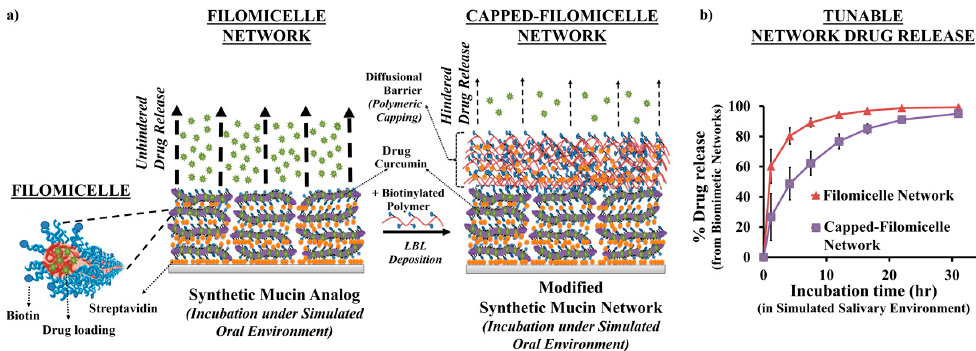
Figure 9. Potential synthetic mucin analogs as a tunable drug releasing network ( a ) Scheme showing use of filomicelle networks formed from crosslinking of biotinylated micelles with streptavidin, as a synthetic mucin analog. And, modification of those analog systems using polymeric capping barriers formed atop synthetic mucin. Capping barriers are formed from crosslinking of biotinylated polymer poly(acrylic acid) with streptavidin via LBL depositions; ( b ) Figure shows modification of drug release capacity from synthetic mucin systems for localized oral drug delivery applications. By developing polymeric capping barrier, the drug release from micelle-based network was greatly hindered, suggesting its capable potential to serve as tunable release systems for mucosal specific regenerative applications such as xerostomia and oral mucositis. Reprinted with permission from Reference [84]. Copyright © 2015, Wiley-VCH Verlag GmbH & Co. KGaA, Weinheim.